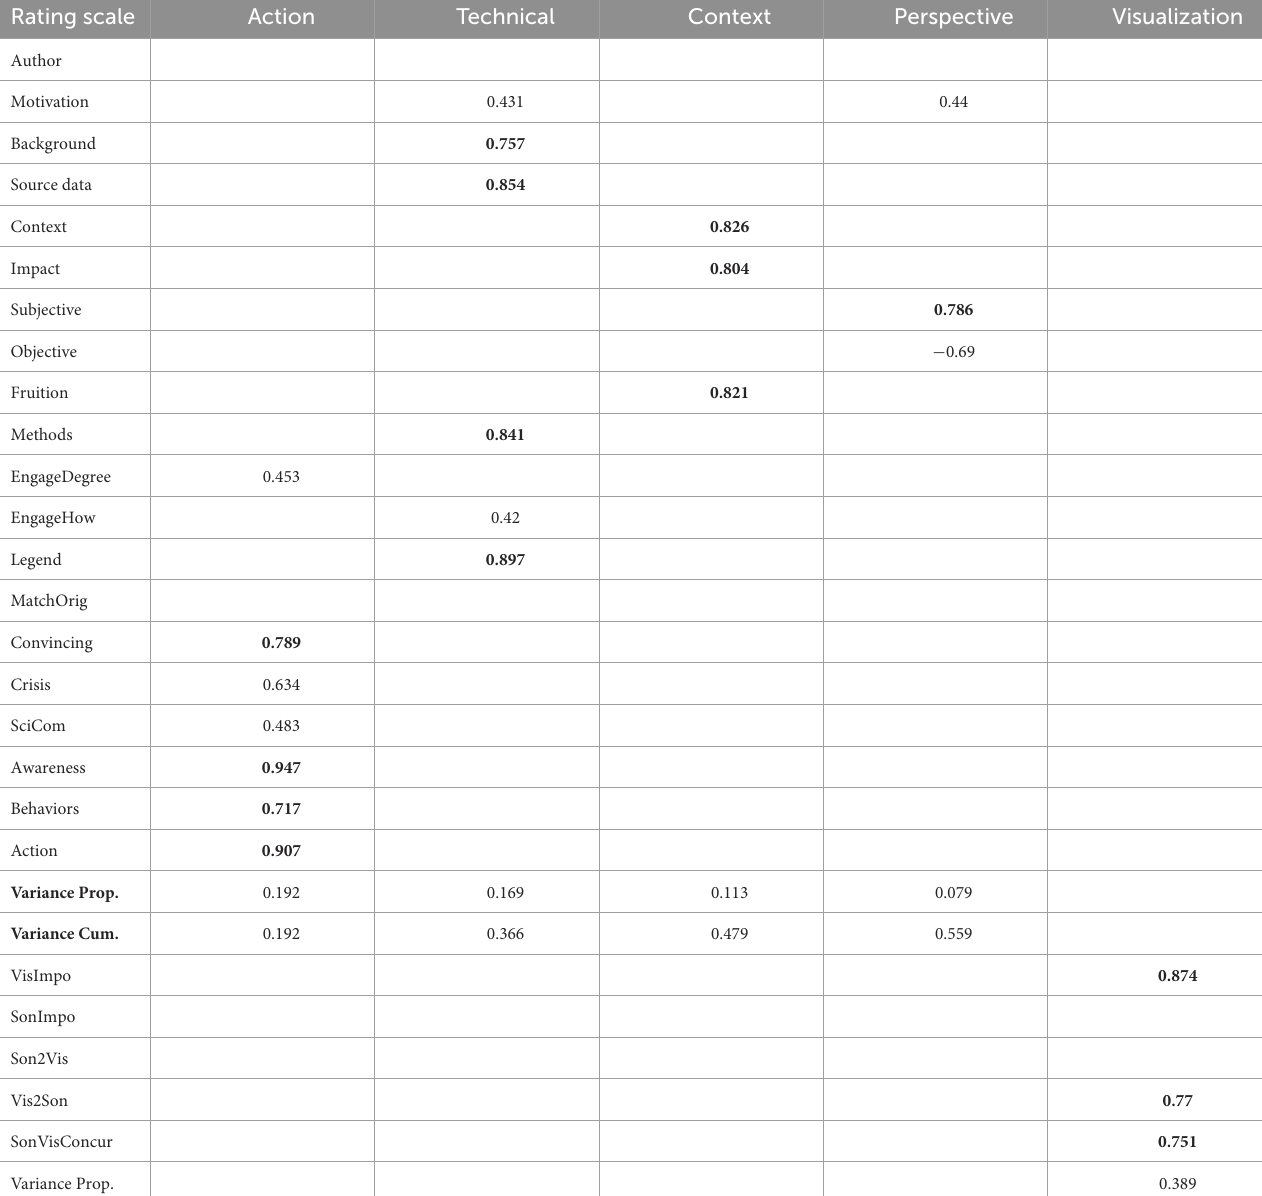
TABLE 3 Exploratory factor analysis of ratings of qualitative characteristics in 32